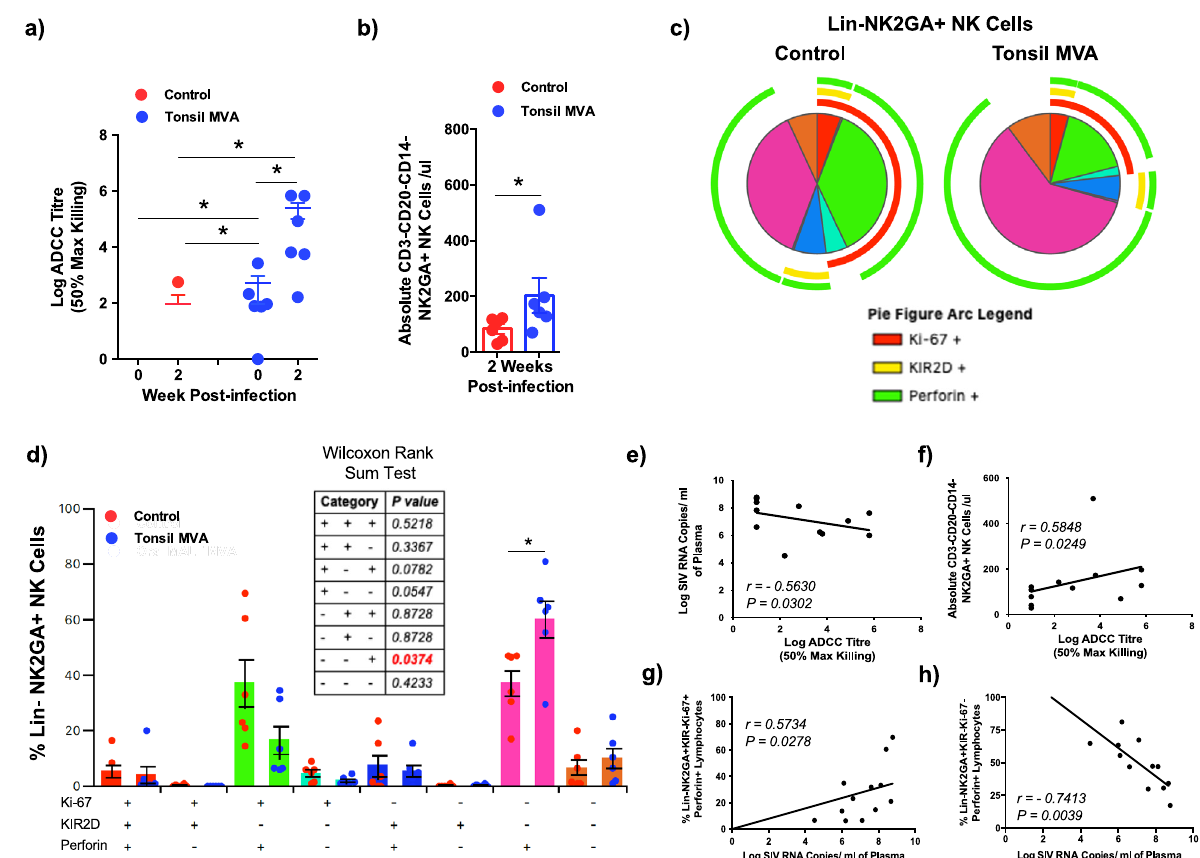
Fig. 5 | Tonsil vaccination induced high levels of ADCC and NK cell responses that inversely correlated with acute plasma viremia. ( a ) Log ADCC titre (50% maxkilling)incontrol( n =6)andtonsilvaccinated( n =6)animalsat0and2weeks post infection. Data are presented as mean values +/ – standard error.